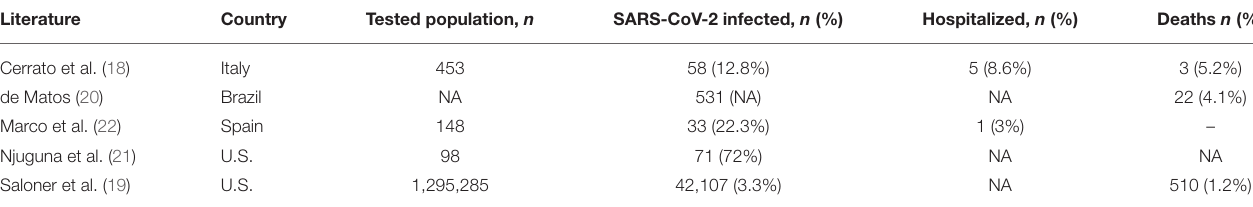
TABLE 1 | Studies on SARS-CoV-2 spread in prison settings revised in our literature search (values calculated from available data). Literature